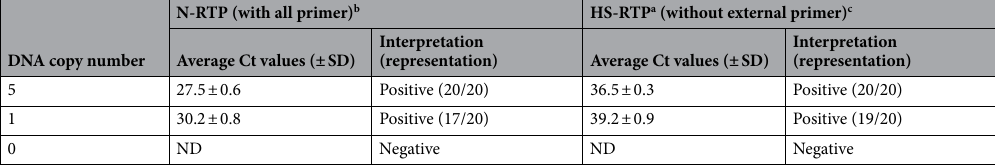
Table 2. Limit of detection of IS6110 -qPCR assay. Ct, Cycle threshold; SD, Standard Deviation; ND, not determined. a High sensitive real-time PCR condition were described by Wang et al. 2019. b All primers contain NF6110, NR6110, IS4F, IS4R, IS4P, Ld2F, Ld2R, RPLd. c External primers (NF6110 and NR6110) were replaced by TE buffer.